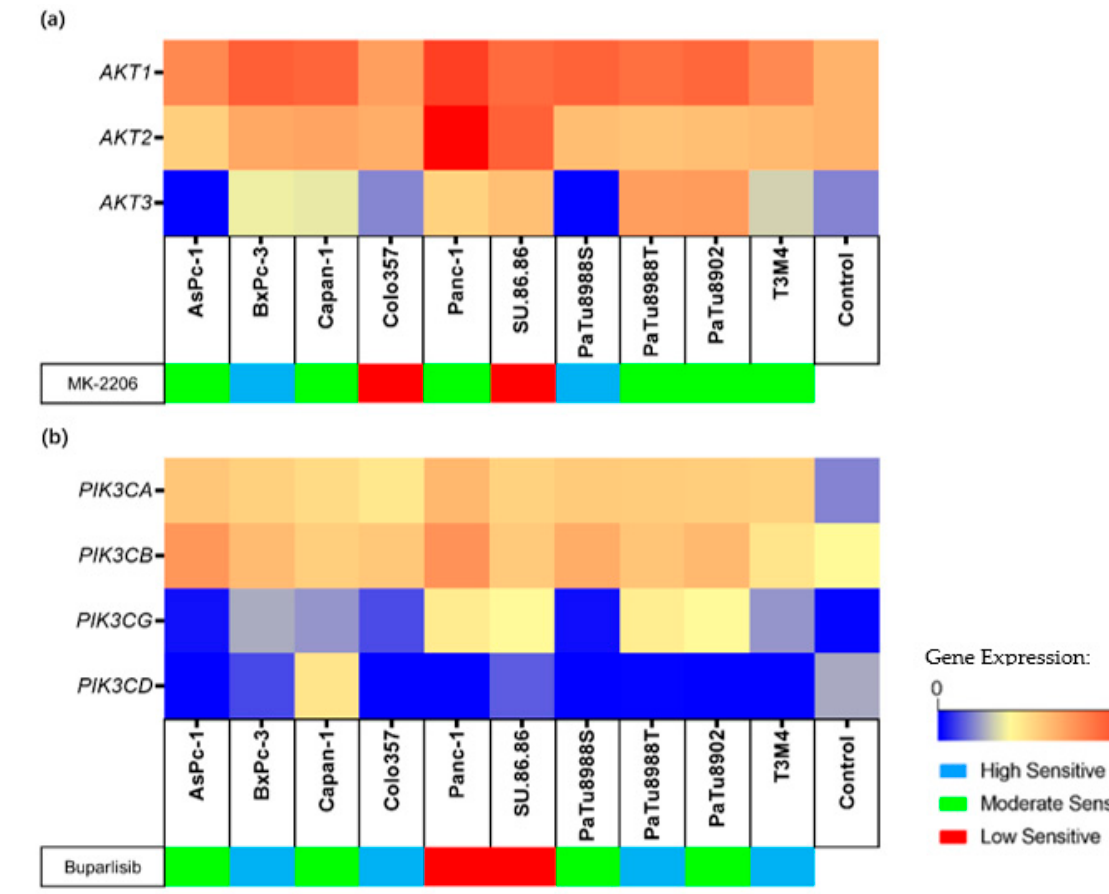
Figure 3. Gene expression levels of inhibitor target genes in cell lines and control. The different sensitivities to MK-2206 ( a ) and Buparlisib ( b ) are indicated for each cell line. Gene expression levels are displayed as Log 2 (TPM + 1). Control: non-neoplastic pancreatic tissue. Gene expression in normal pancreatic tissue comes from GTEx and TCGA databases.